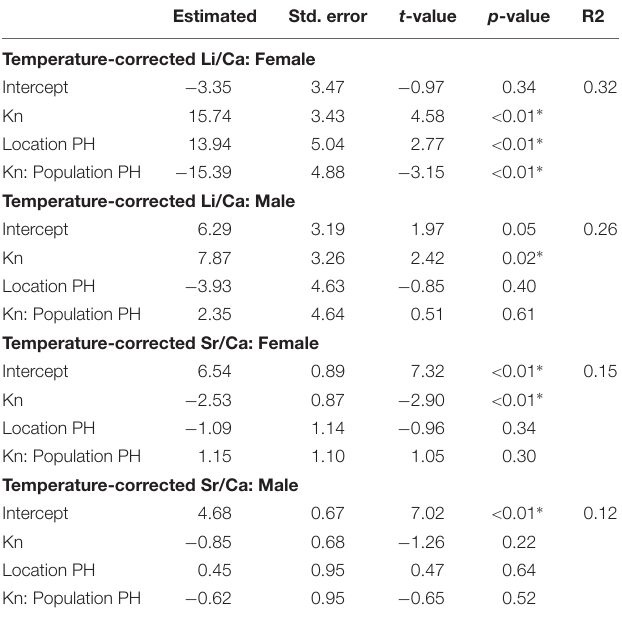
TABLE 5 | Multiple linear regression analyses of temperature-corrected cuttlebone Me/Ca (element/calcium) with Kn (relative growth condition) values between two populations (DG and